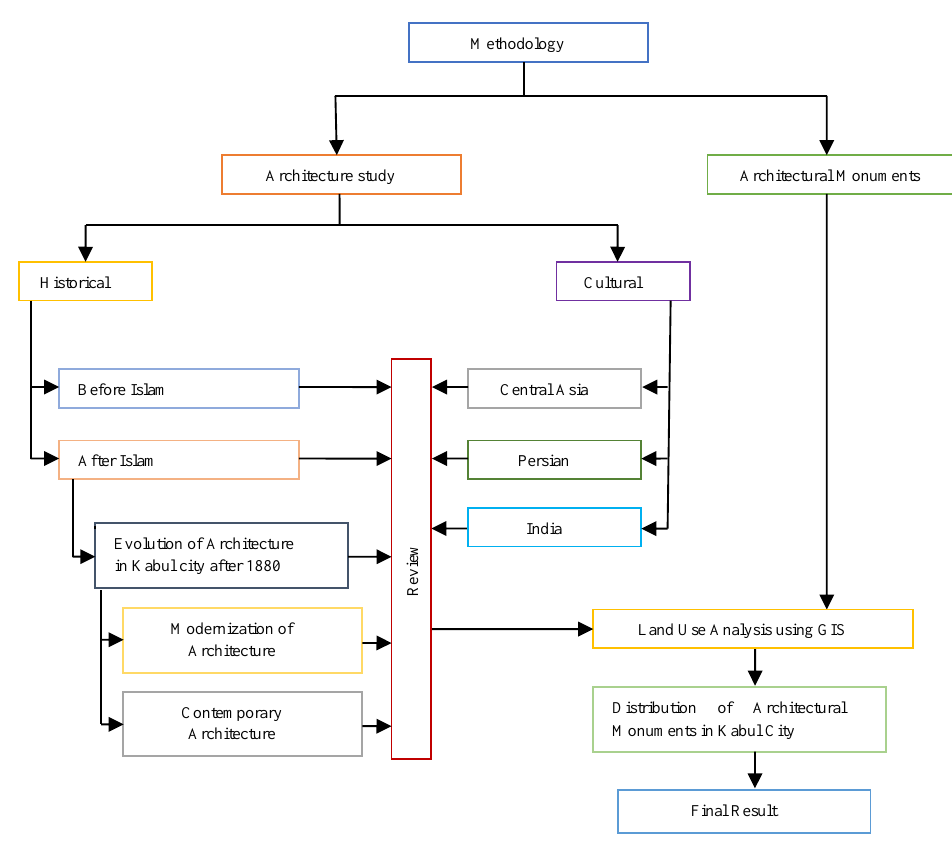
Figure 2 Methodology flow